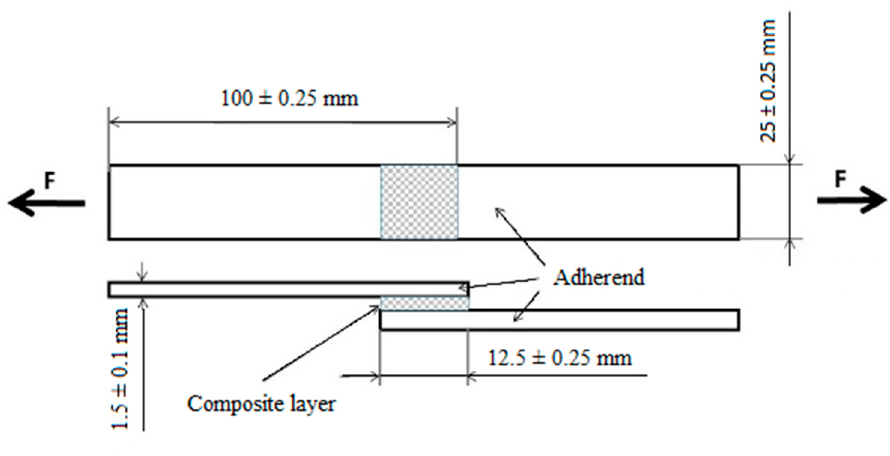
Figure 3. Adhesive bond according to ˇCSN EN 1465 [40]. Table 2. Samples and characteristic of adhesive bonds with eggshells filler.